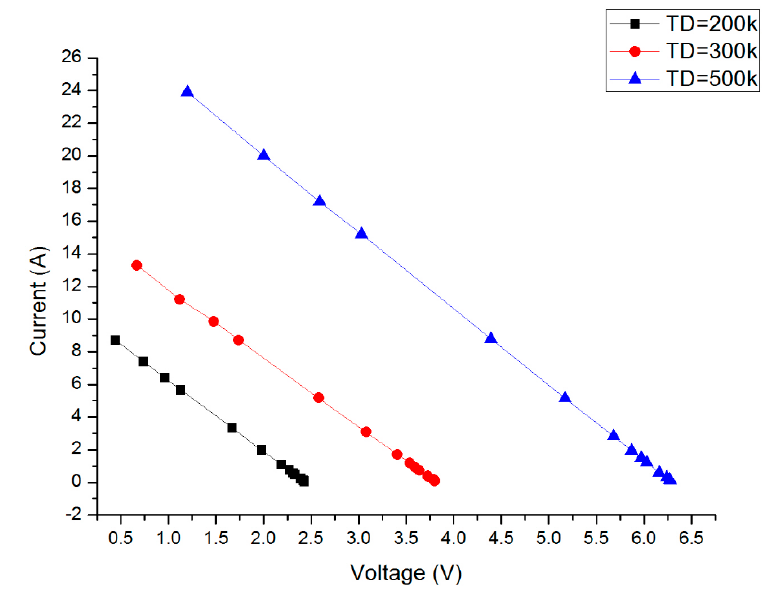
Figure 7. Current versus output voltage.